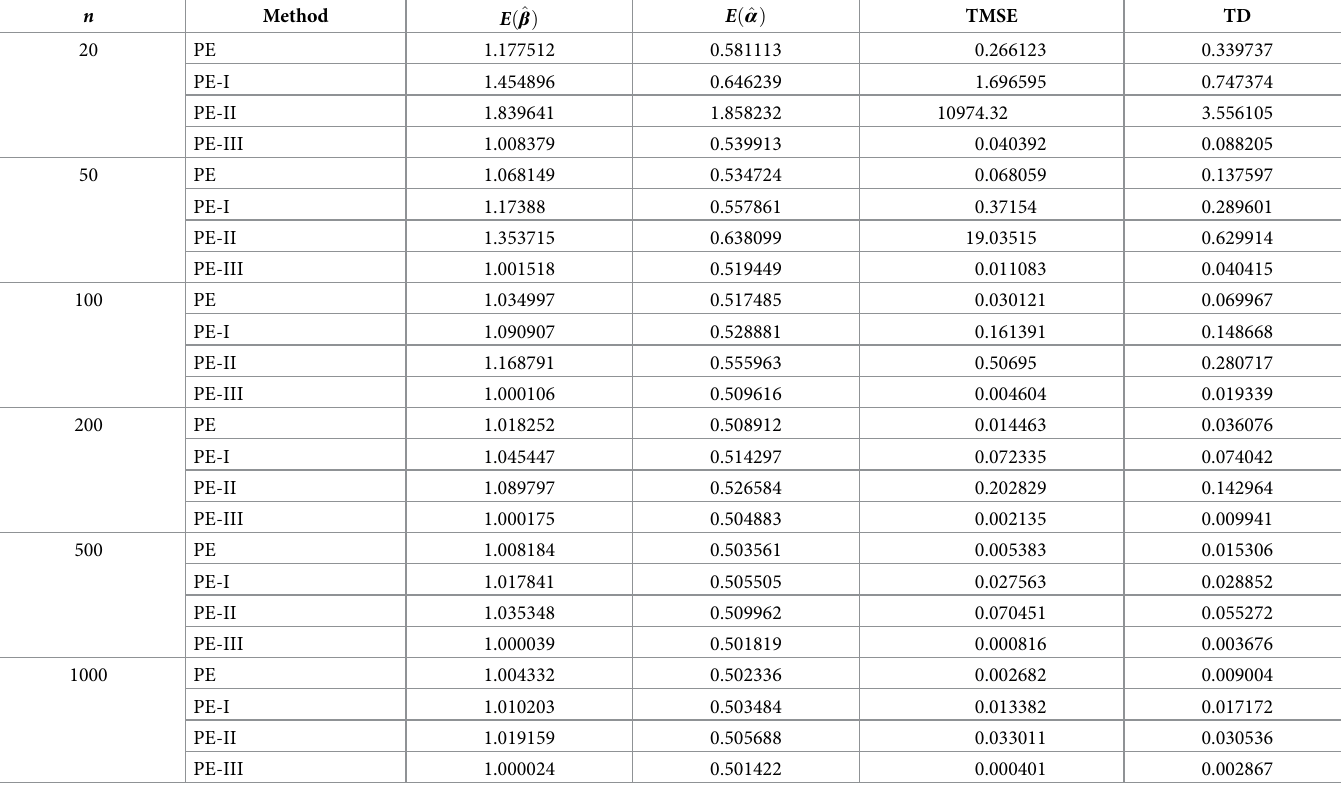
Table 1. Comparison of PE and modified PE for β = 1, α =